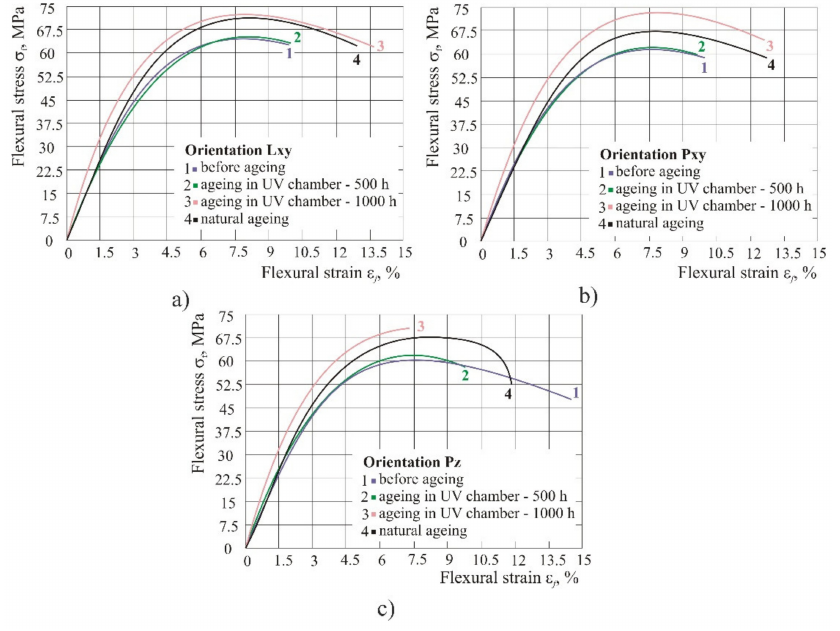
Figure 10. The diagram of flexural stress–strain of test specimens with the use of original material in the case of UV radiation: ( a ) orientation Lxy, ( b ) orientation Pxy, ( c ) orientation